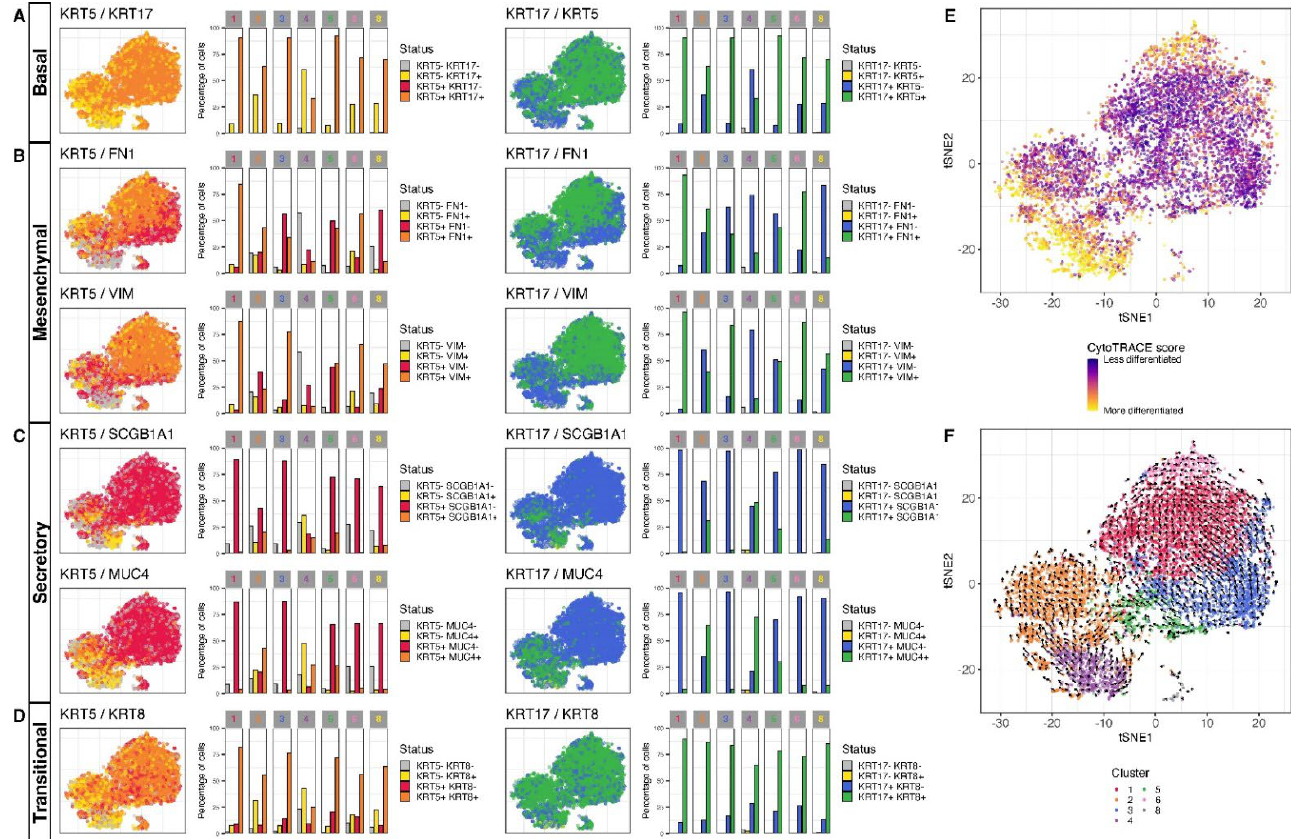
Figure 3. Co-expression of specific marker and differentiation states and trajectory in alveolar basal cells cultured in DMEM growth medium. tSNE showing co-expression patterns of ( A ) KRT5 and KRT17 with ( B ) FN1, VIM, ( C ) SCGB1A1, MUC4 or ( D ) KRT8. A log-normalized expression level of 0.5 was used to call genes expressed or not expressed. The relative proportion of cells expressing/co- expressing the different markers across clusters is shown in bar plots. ( E ) tSNE showing the CytoTRACE differentiation state scores across cells. ( F ) tSNE overlaid with the embedded velocity vectors of the RNA velocity showing the differentiation trajectories inferred from comparison of spliced and unspliced signal across genes in single cells. A grid-based approach is used to summarize the per-cell vectors into local representatives for effective visualization.